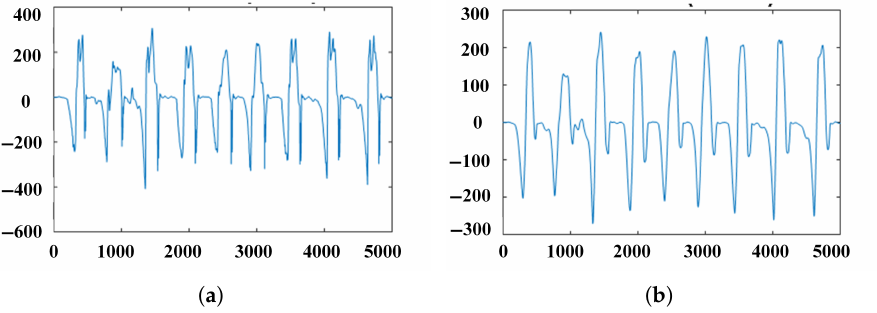
Figure 6. Angular velocity signal ( a ) Before preprocessing ( b ) After